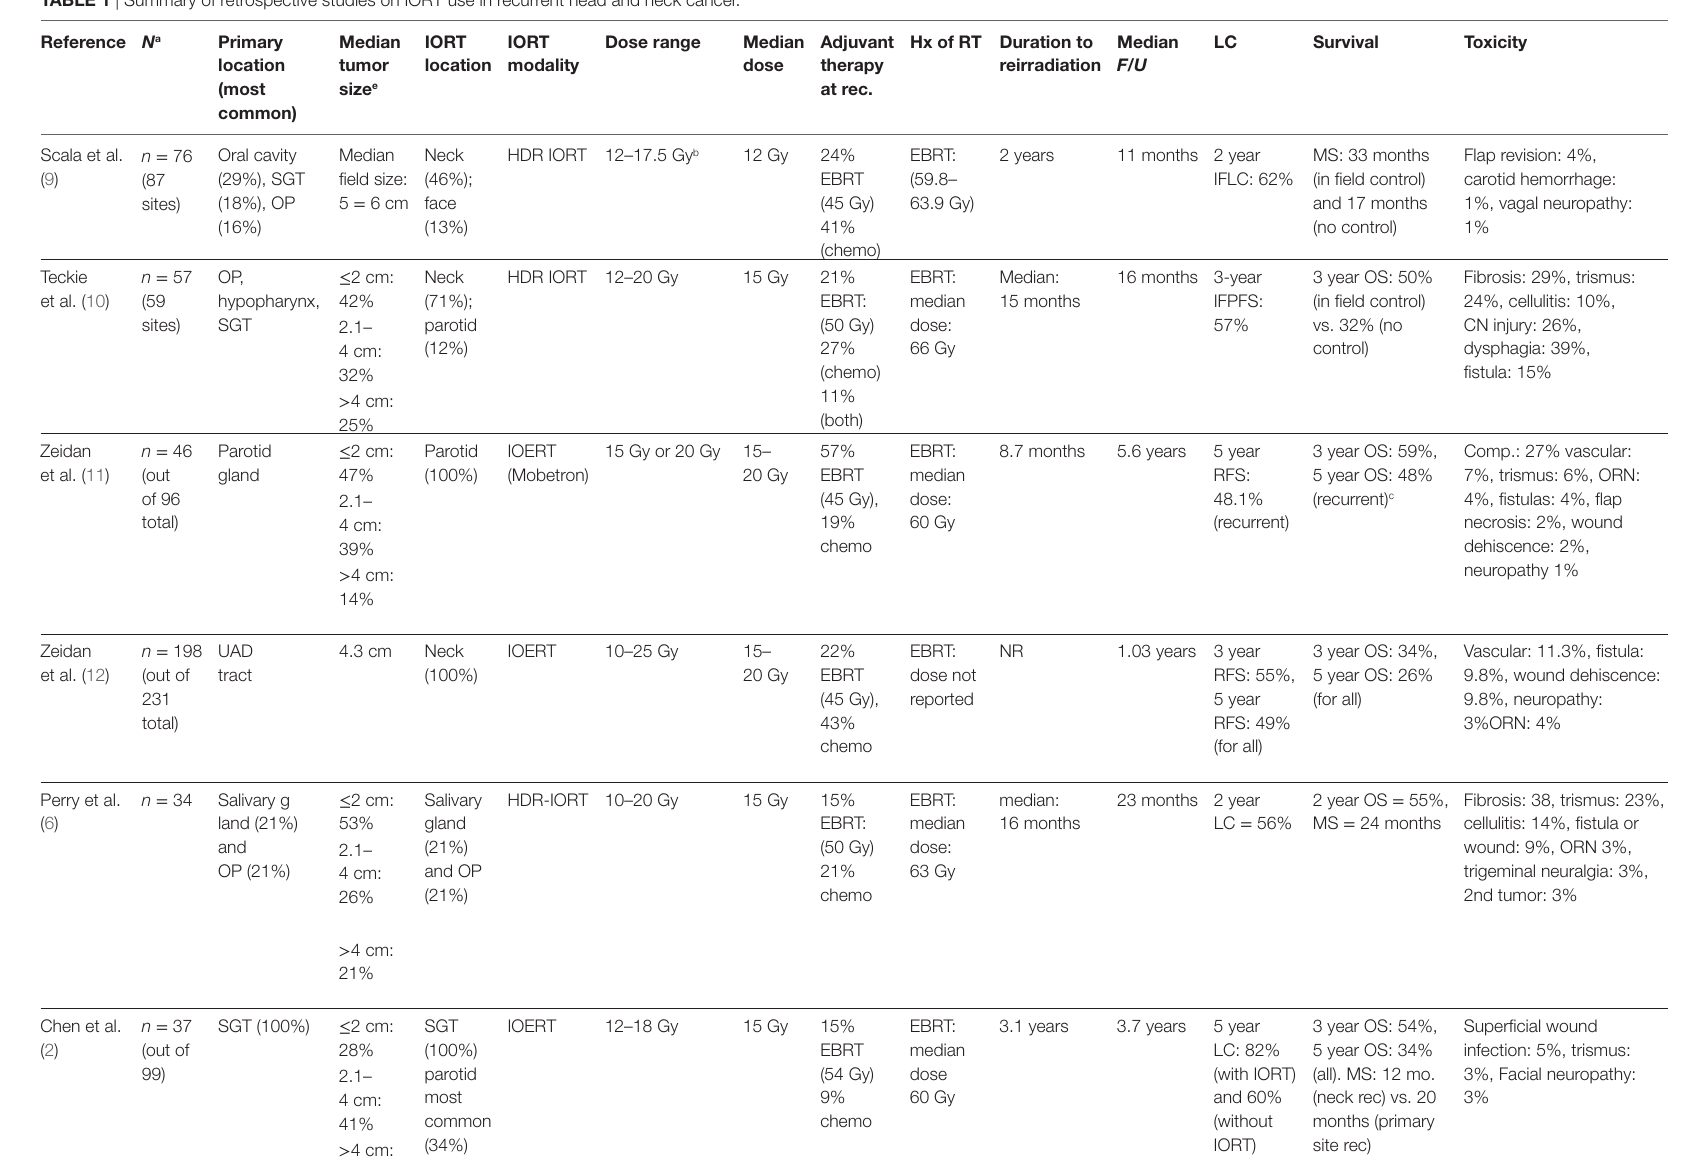
TAbLe 1 | Summary of retrospective studies on IORT use in recurrent head and neck